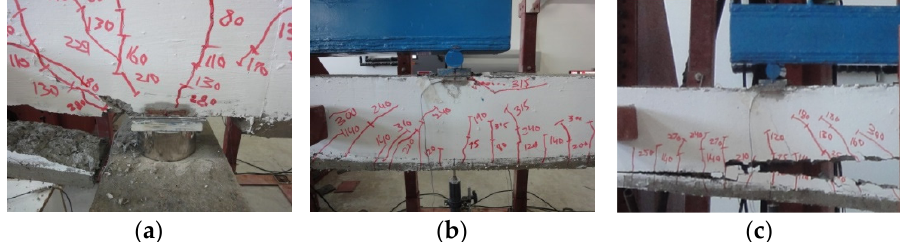
Figure 8. Typical failure modes of the specimens with sagging strengthening (S-C4): ( a ) Localized concrete crushing at hogging; ( b ) Localized concrete crushing at sagging; ( c ) Cover ripping off.